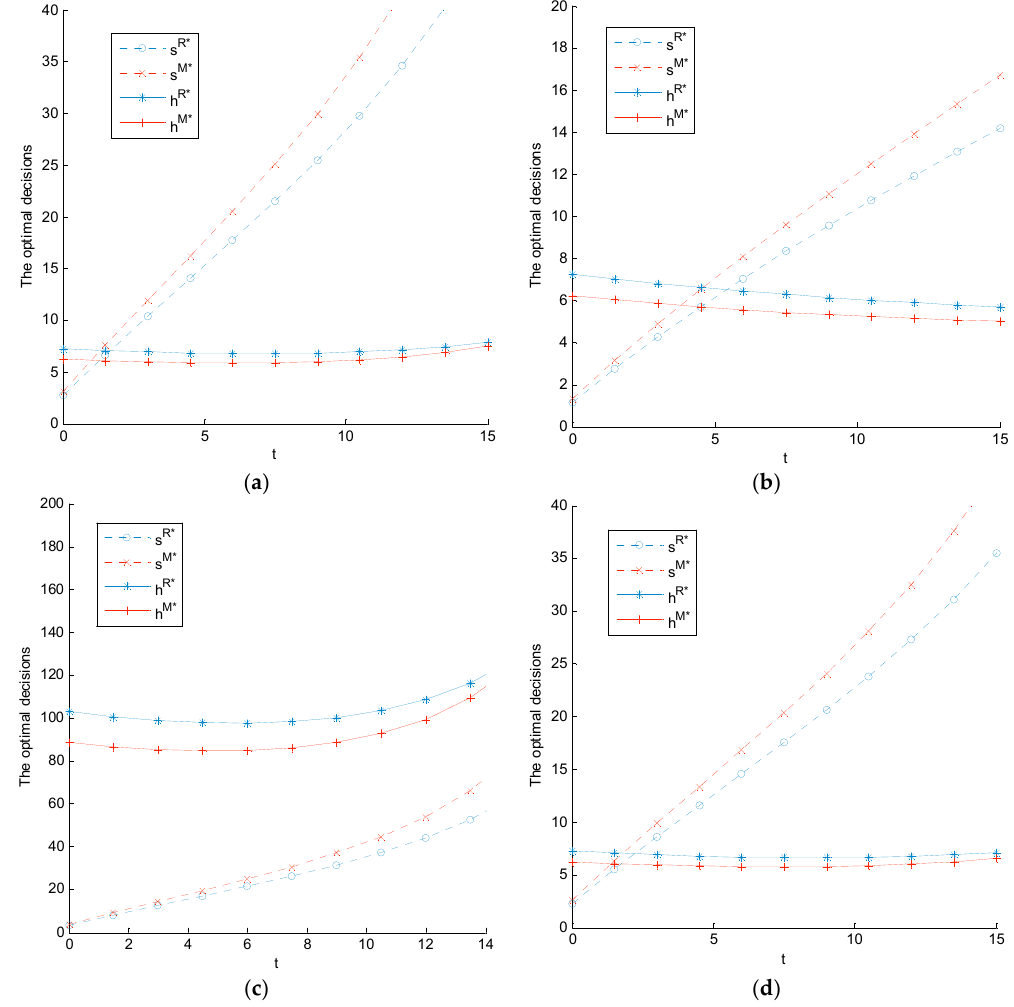
Figure 2. The impact of carbon tax on equilibrium decisions: ( a ) θ = 5 and m = 10; ( b ) θ = 12 and m = 10; ( c ) θ = 6 and m = 1; and ( d ) θ = 6 and m =